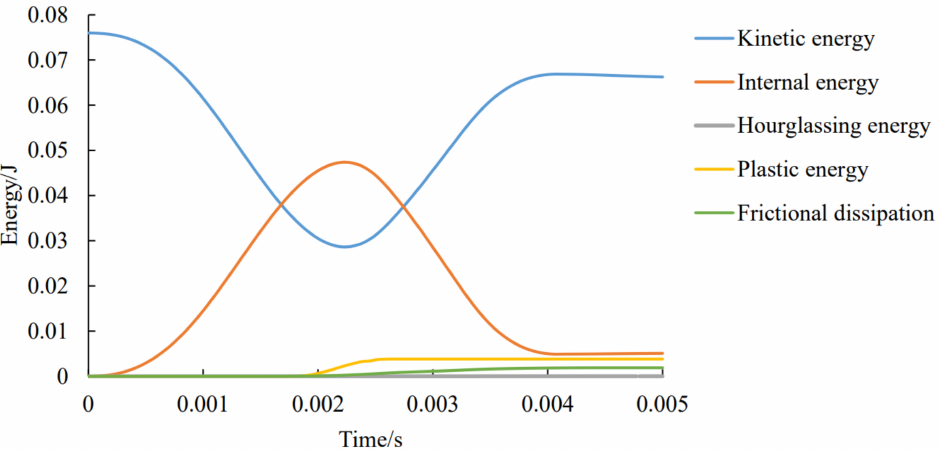
Figure 11. Energy analysis in FEM-based